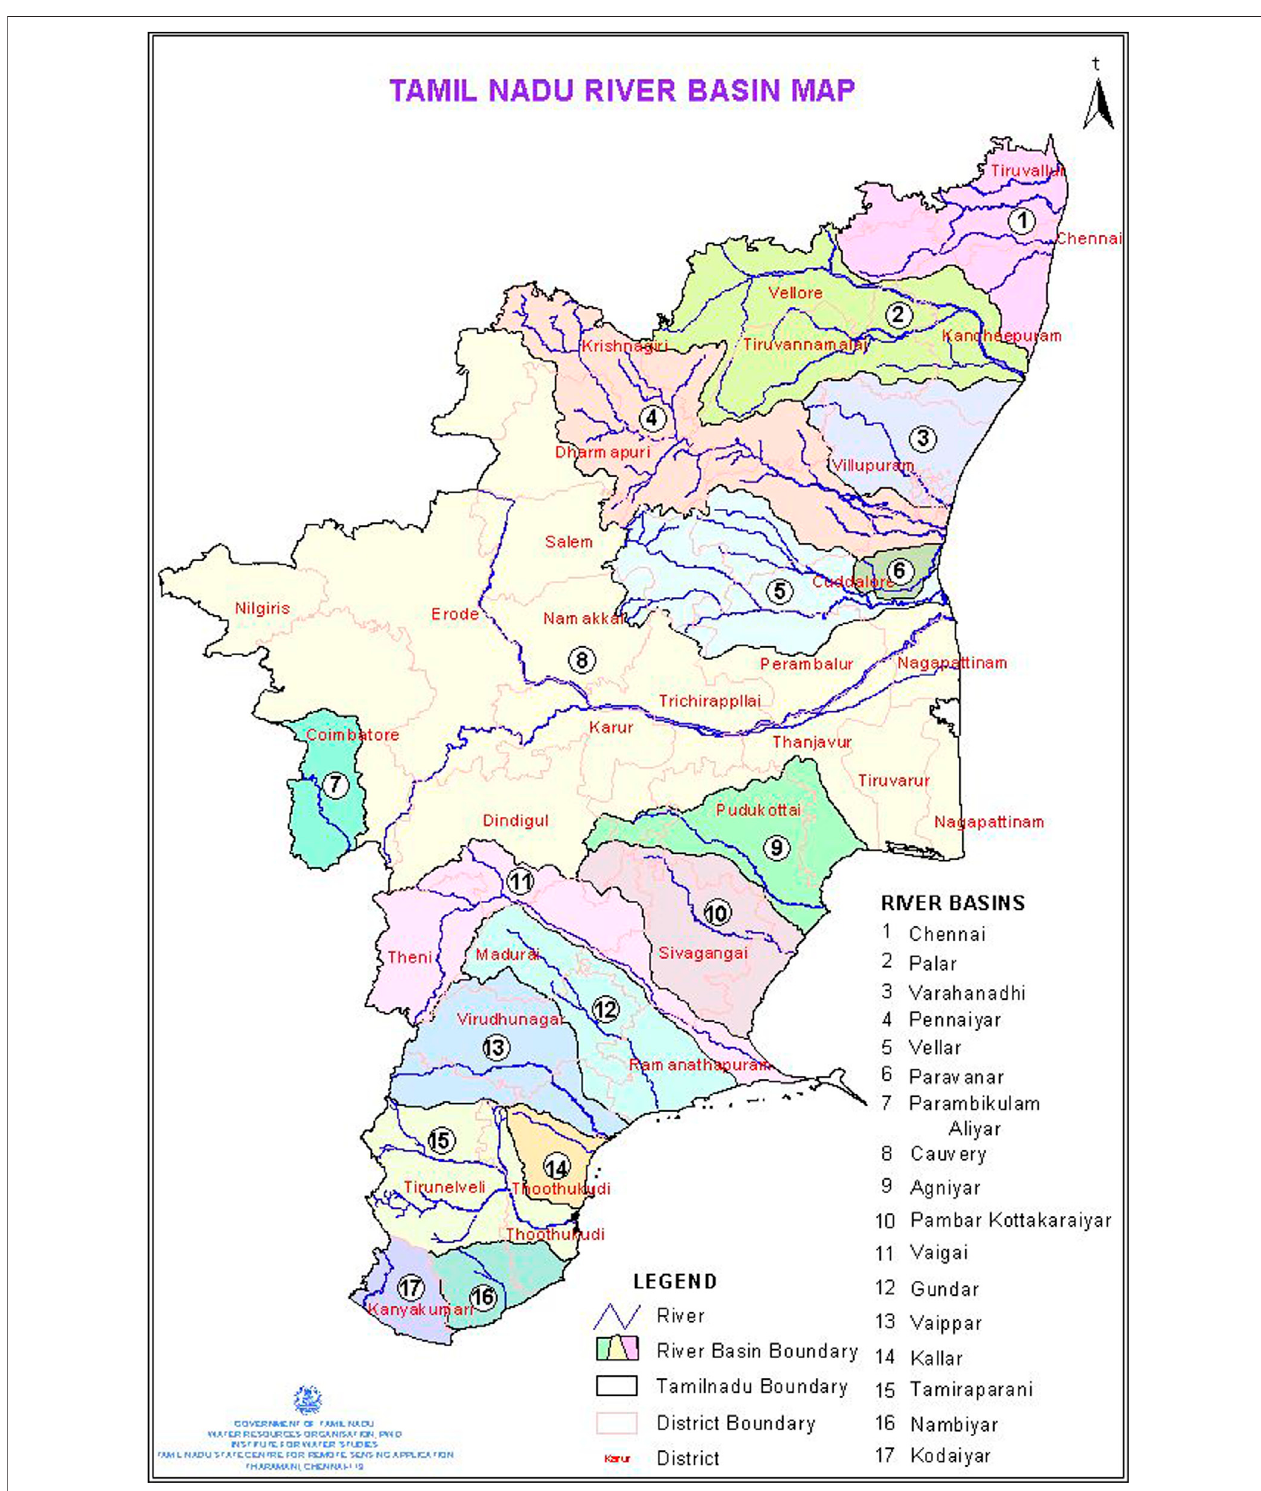
FIGURE 2 | River basin of Tamil Nadu. Source: PWD, Chennai, Tamil Nadu.